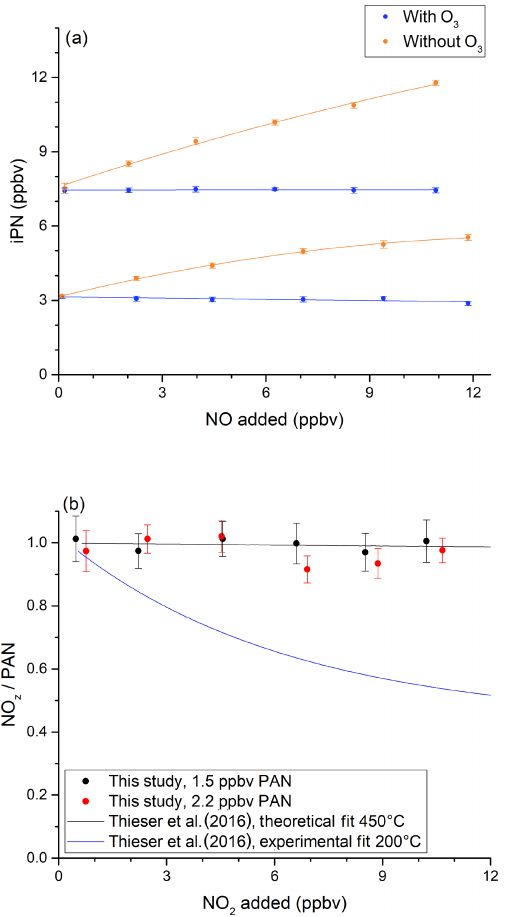
Figure 4. Investigation of bias caused by reactions of NO with HO 2 and RO 2 when measuring iPN. (a) NO varied for two initial iPN mixing ratios in the presence (blue data points) and absence (orange data points) of added O 3 . The NO x background signal from the iPN cylinder was subtracted from the iPN mixing ratios. (b) The investigation of bias caused by the recombination of RO 2 and NO 2 during the thermal decomposition of PAN. In both experiments, the oven temperature was 850 ◦ C. In both plots, the error bars indicate the standard deviation over the averaging